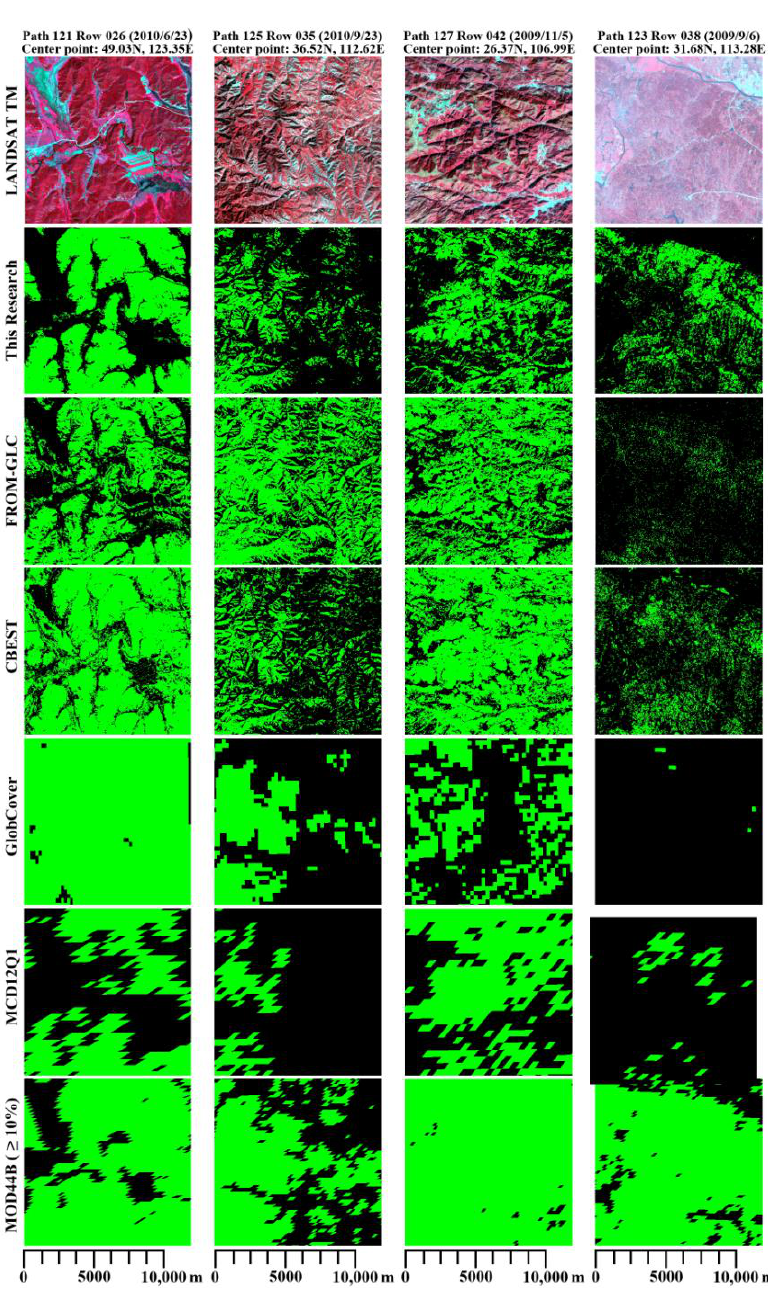
Figure 6. Selected case comparison of forest extent products with this product (Green color represents forest and black represents non-forest.) From left to right, the image segments were selected from Inner Mongolia, Shanxi Province, Guizhou Province, and Hubei